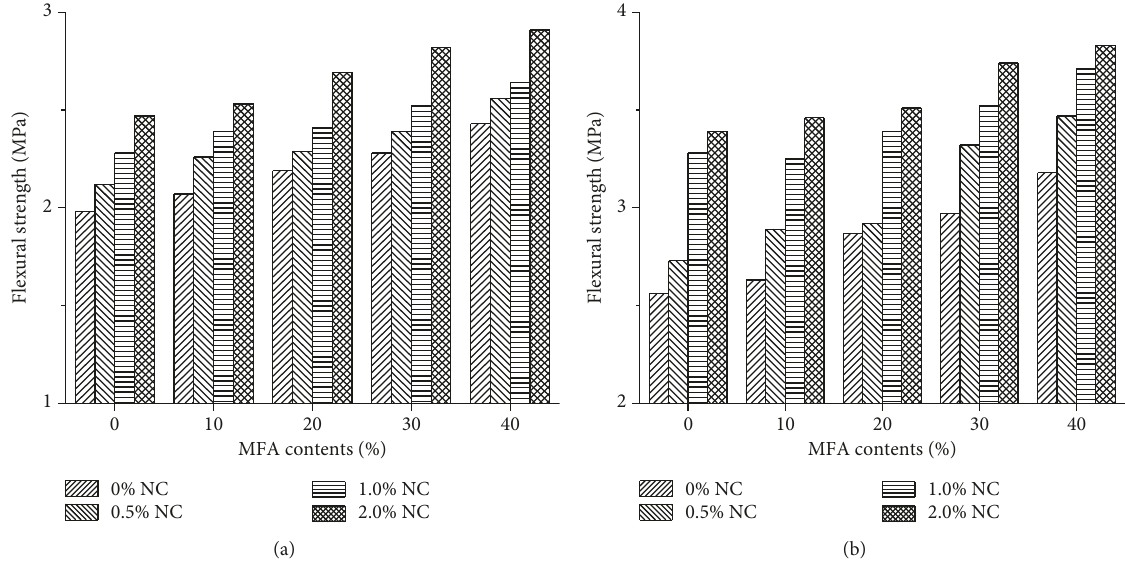
Figure 9: 28-day flexural strength of hardened grouts with a W/S ratio of 1.2: (a) 0% SP; (b) 1.5% SP.